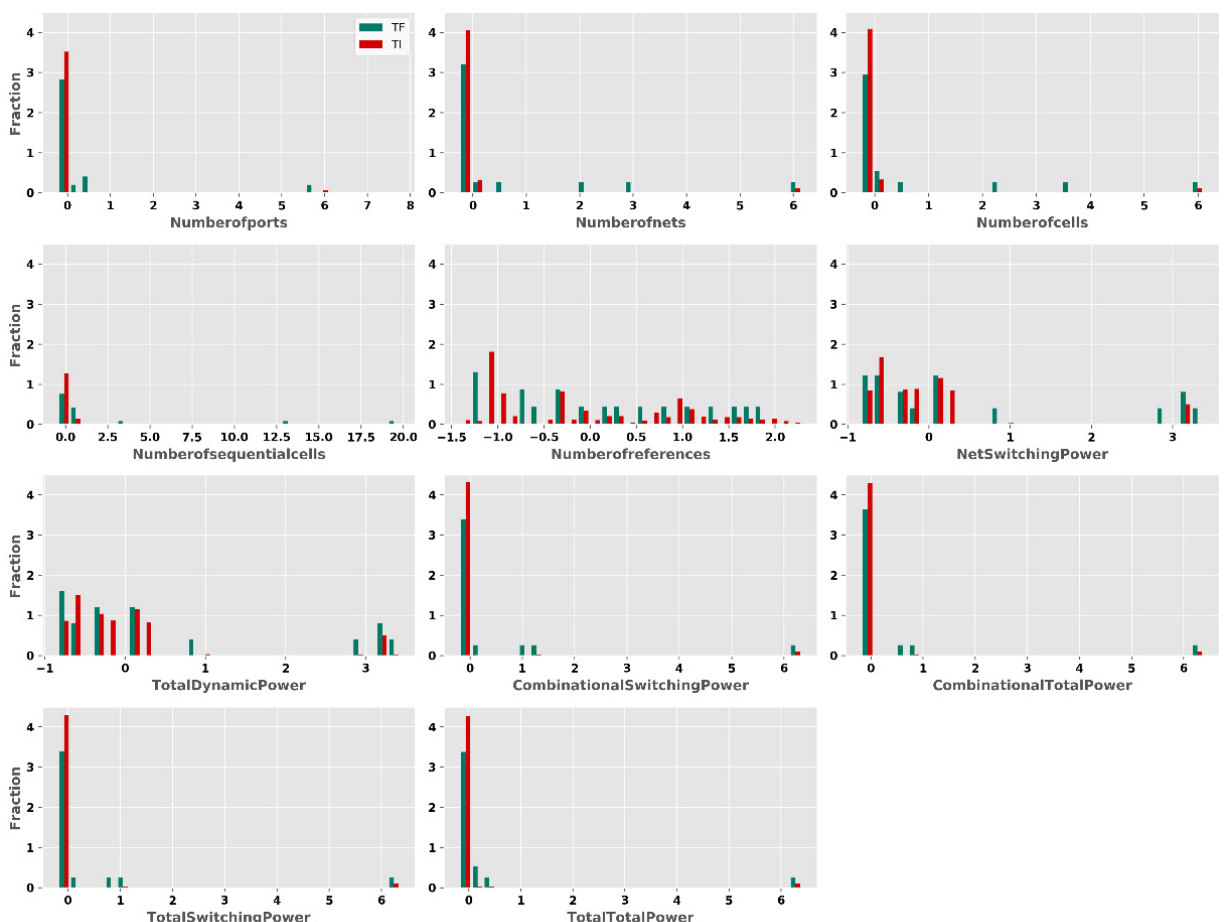
Figure 6. Data distributions by feature and class.